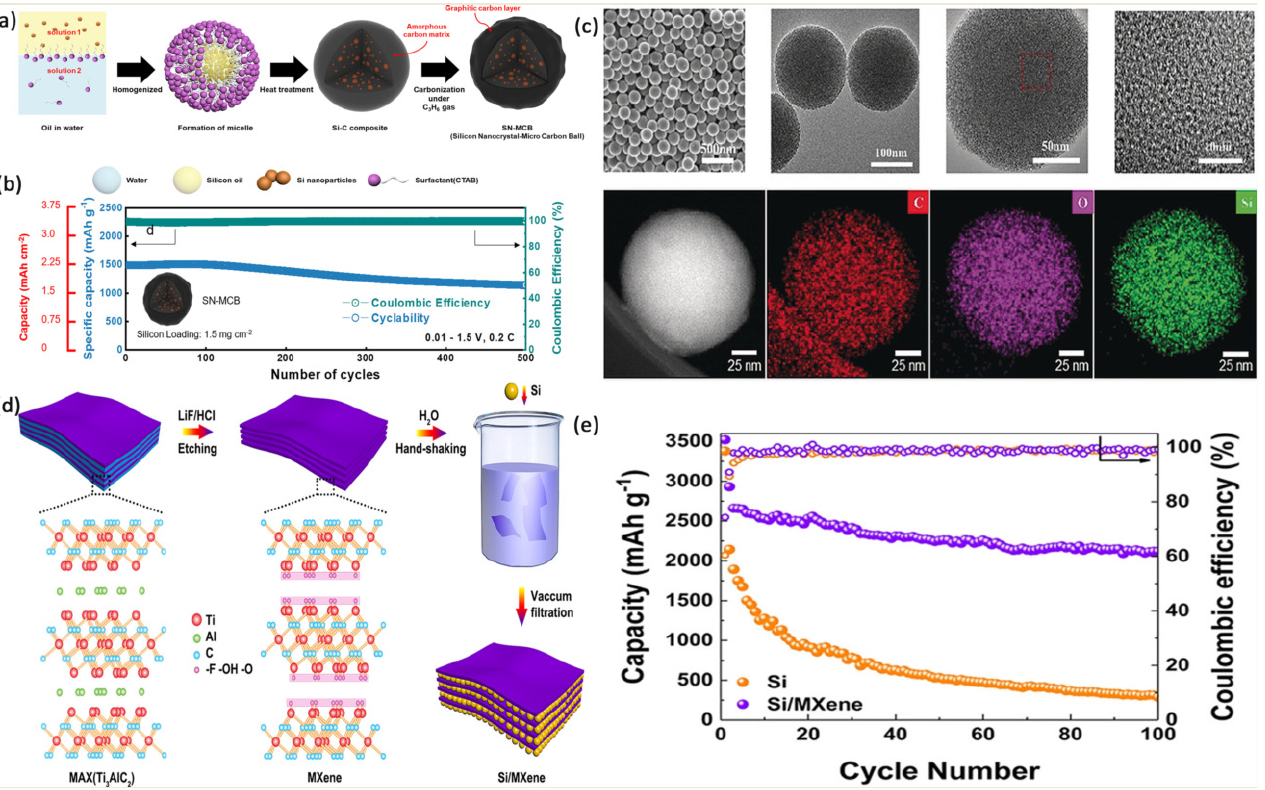
Figure 3. ( a ) Schematic Illustration of the synthesis of the proposed Si/C hybrid composite. Repro- duced with permission [83]. Copyright 2019, ACS Publications. ( b ) Long-term cycling stability of the anodes in half-cells over a voltage range of 0.01–1.5 V at 0.2 C, and ( c ) the first row shows the field emission SEM images, TEM images and high-resolution TEM images of ASD-SiOC nanocomposites, and the second row shows the dark-field TEM images and corresponding elemental profiles of individual ASD-SiOC nanocomposite particles. Reproduced with permission [85]. Copyright 2019, Wiley Online Library. ( d ) The schematic diagram for preparing Si/MXene composite paper, and ( e ) cycling stability of Si/MXene and pure Si anodes at 200 mA·g − 1 . Reproduced with permission [86]. Copyright 2019, ACS Publications.